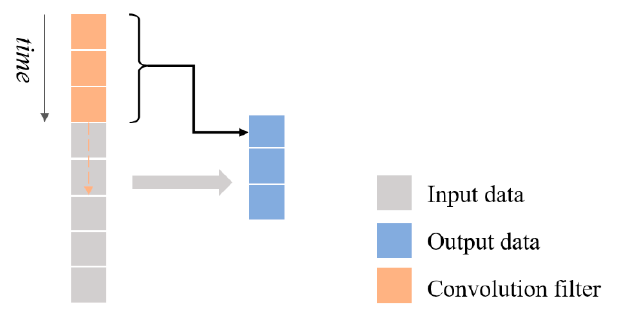
Figure 7. General process of 1D convolution for temporal data.